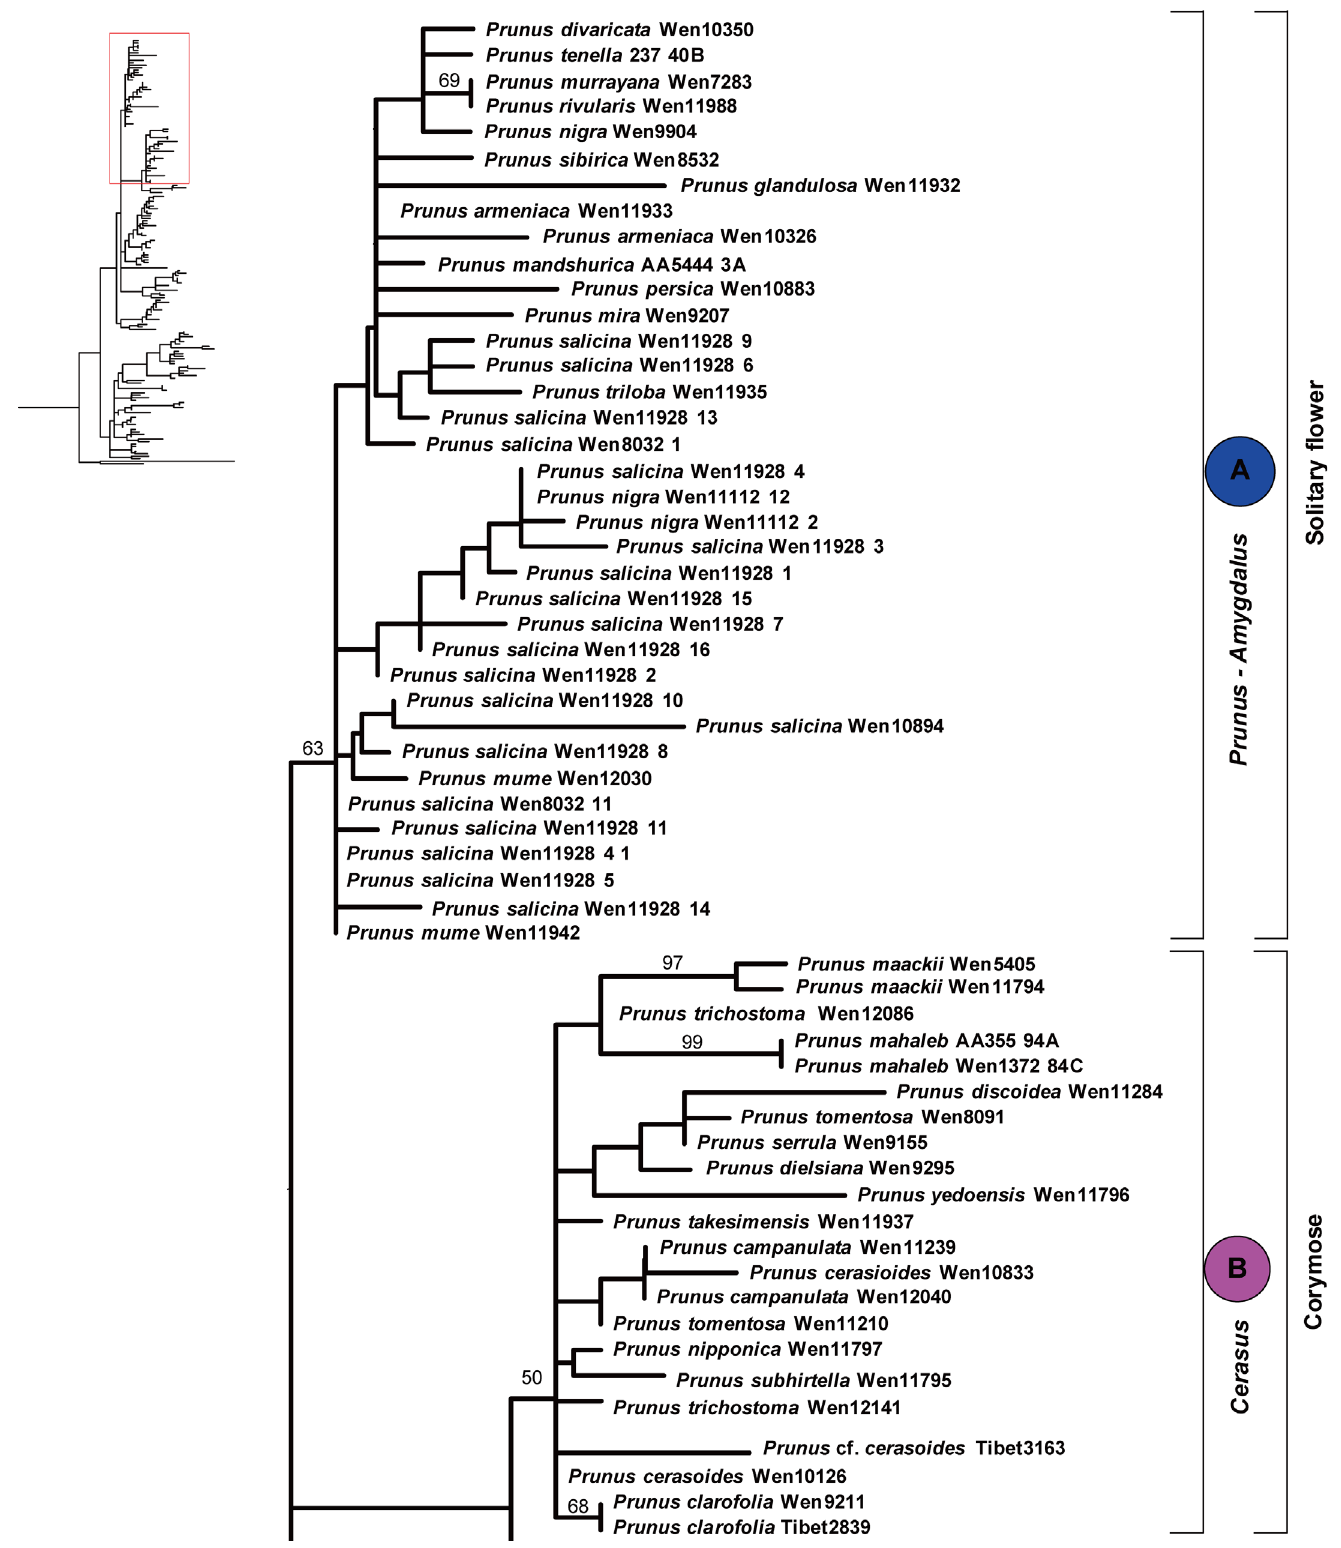
Fig 2. Maximum likelihood (ML) tree inferred from the At103 DNA sequences of Prunus . The results of ML bootstrap analysis are shown above the branches. Bootstrap values > 50% are shown. doi:10.1371/journal.pone.0157123.g002 PLOS ONE | DOI:10.1371/journal.pone.0157123 June 13,